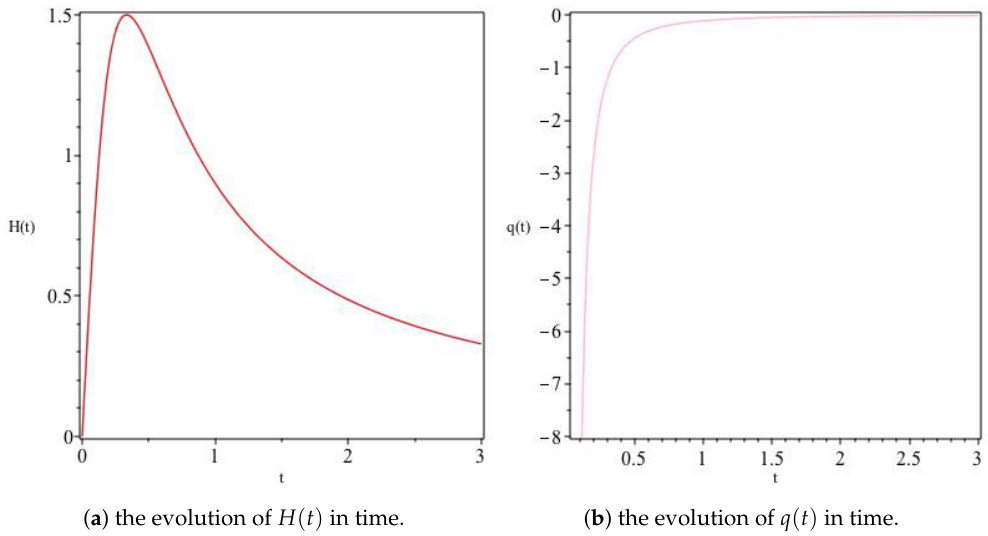
Figure 6. The variation of H and q for Model I. For the model with α , β and γ all normalized to unity, we get an initially accelerated expanding solution reaching a finite maximum value and eventually contracting asymptotically towards a vanishing q as depicted by the left and right panels above.